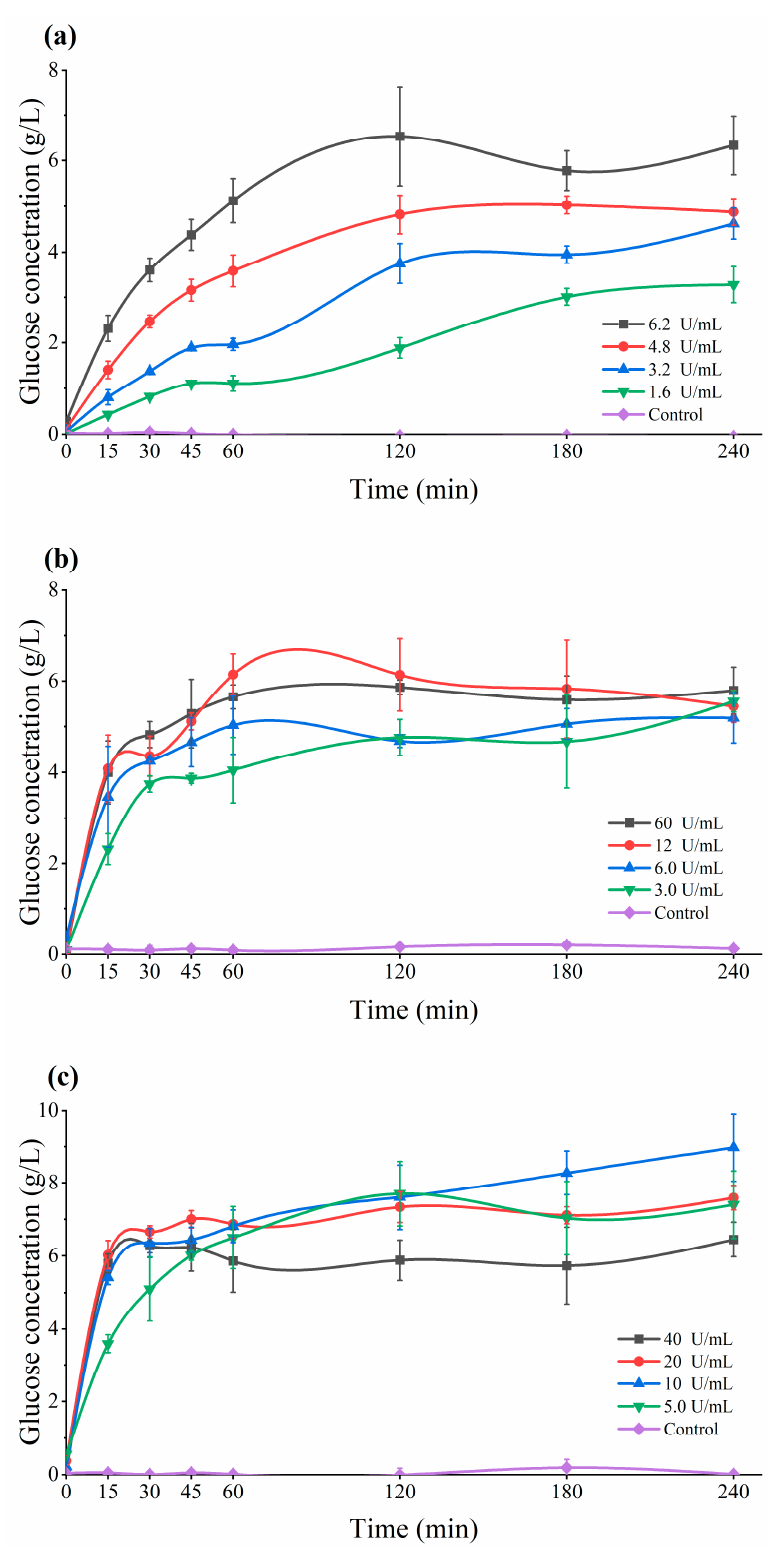
Figure 2. The effect of different amount units of β -D- Fru, β -Gal, and GLA on substrate conversion to simple sugars in HS medium with sucrose ( a ), lactose ( b ), and starch ( c ) as carbon sources.